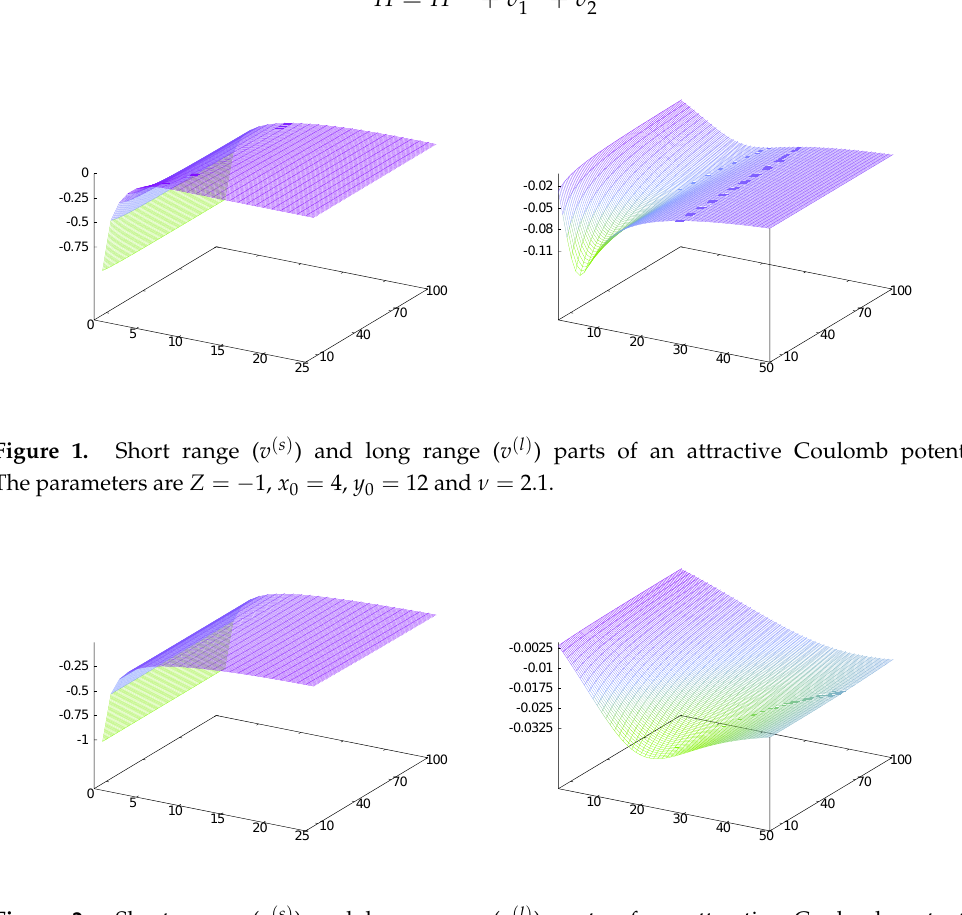
Figure 2. Short range ( v ( s ) ) and long range ( v ( l ) ) parts of an attractive Coulomb potential. The parameters are Z = − 1, x 0 = 15, y 0 = 35 and ν = 2.1. So, we split the wave function into two components